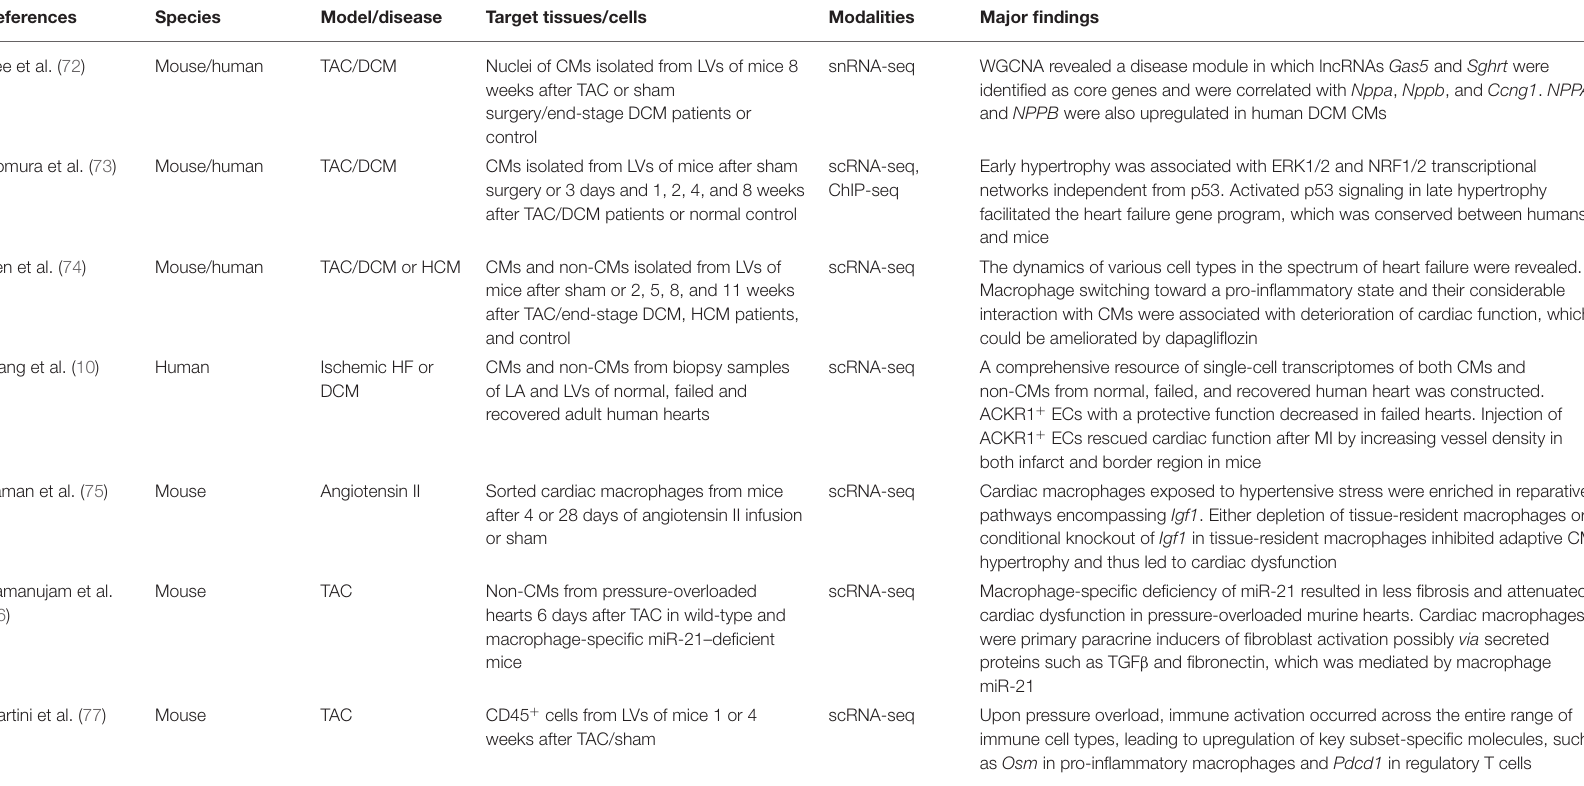
TABLE 4 | Summary of studies of heart